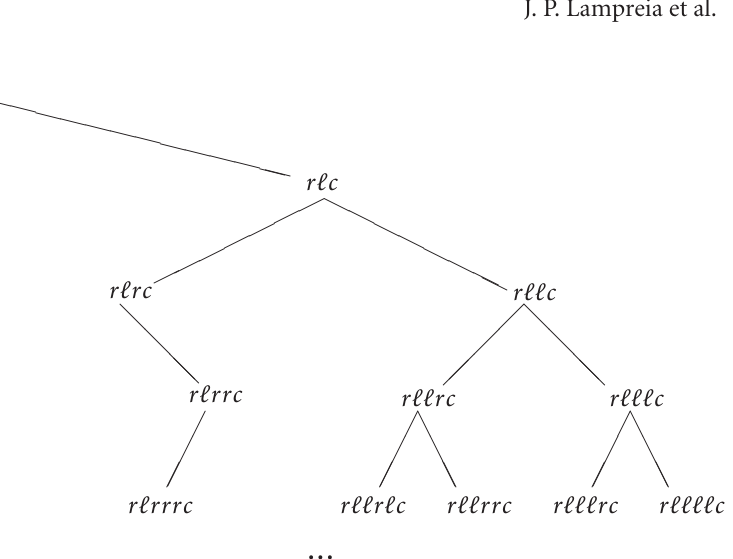
Figure 3.1. The tree (cid:6) of unimodal kneading